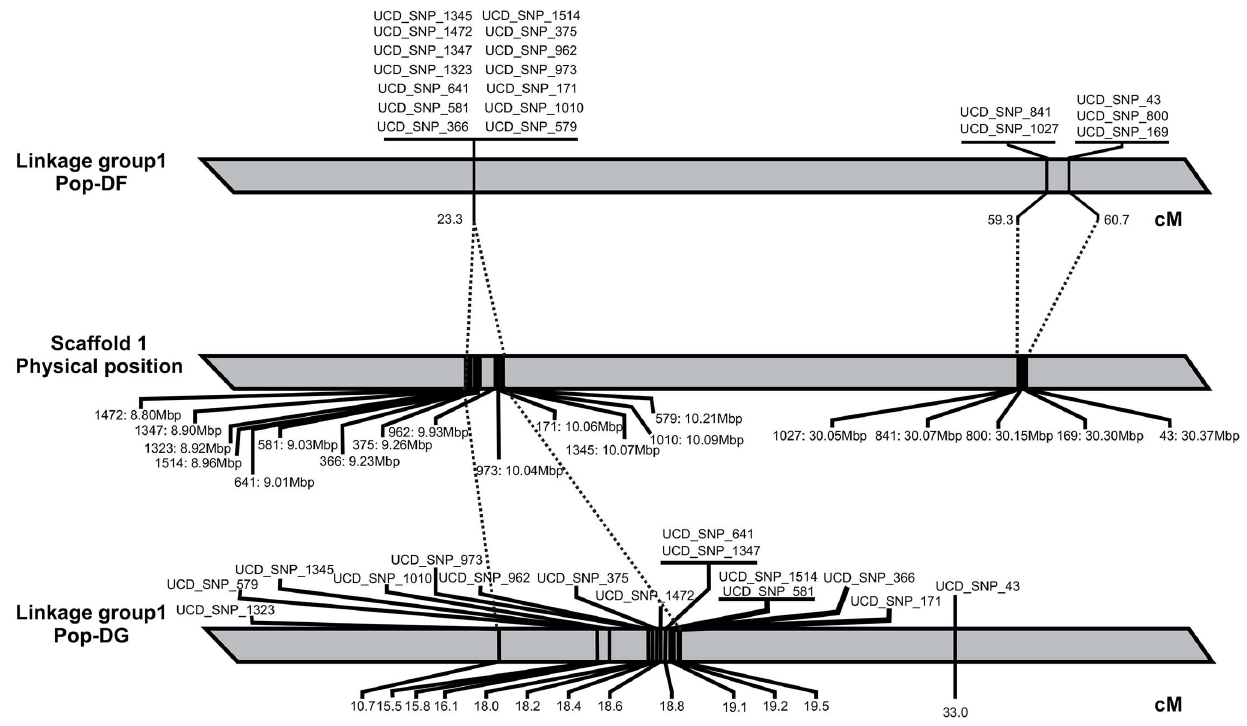
Figure 4. Physical map position of the QTLs. Comparison of genetic map positions of SNPs associated with Brown rot resistance on linkage group 1 of Pop-DF, with their physical map positions on chromosome 1 and their positions in linkage group 1 of Pop-DG.